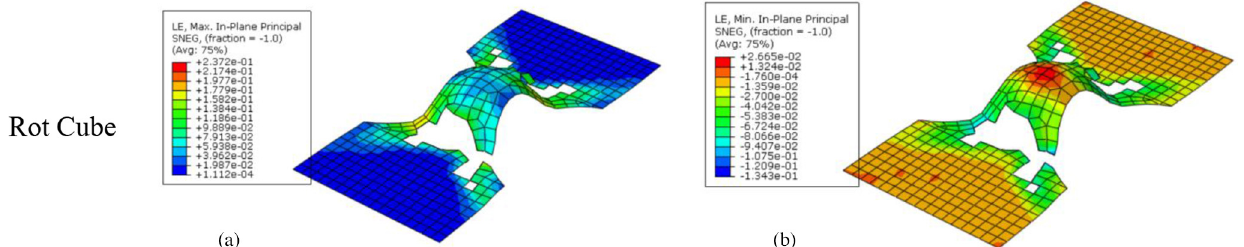
Fig. 10. (a) Maximum in-plane principle strain under uniaxial stretching. (b) Minimum in-plane principle strain under uniaxial stretching.